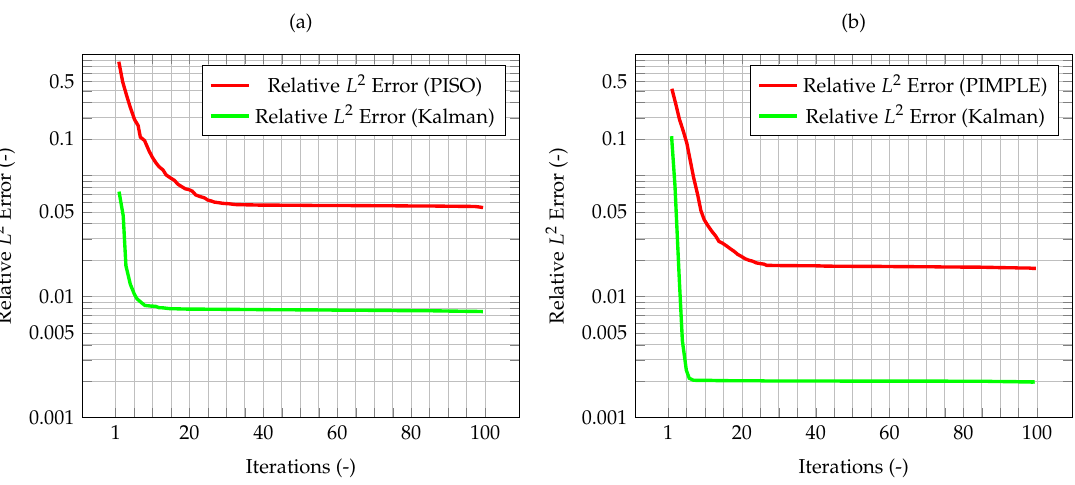
Figure 9. Time evolution of the average Kalman gain for the PISO algorithm ( a ) and the PIMPLE algorithm ( b ) with time adaptivity and initial time step equal to 0.01 s.